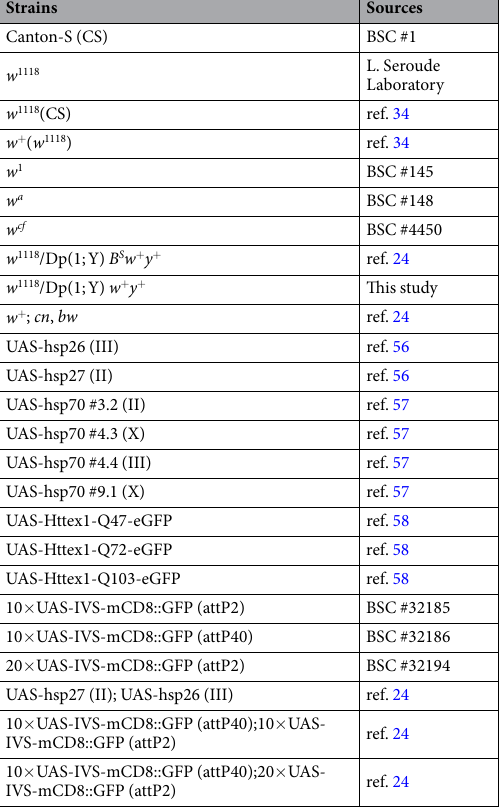
Table 1. Fly strains used in this study and their sources. BSC, Bloomington Stock Center; attP2, Site- specific recombination site in the third chromosome; attP40, Site-specific recombination site in the second chromosome; ref,